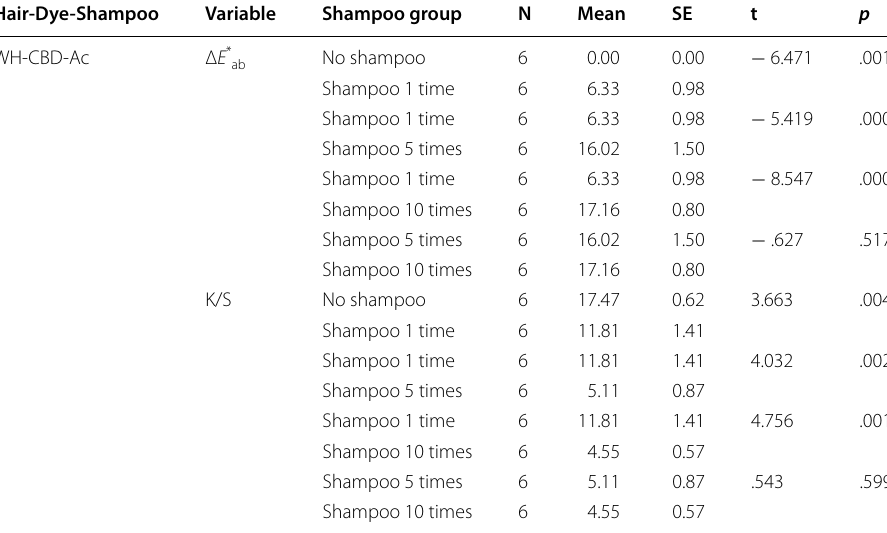
and K/S values between the groups with different number of ab